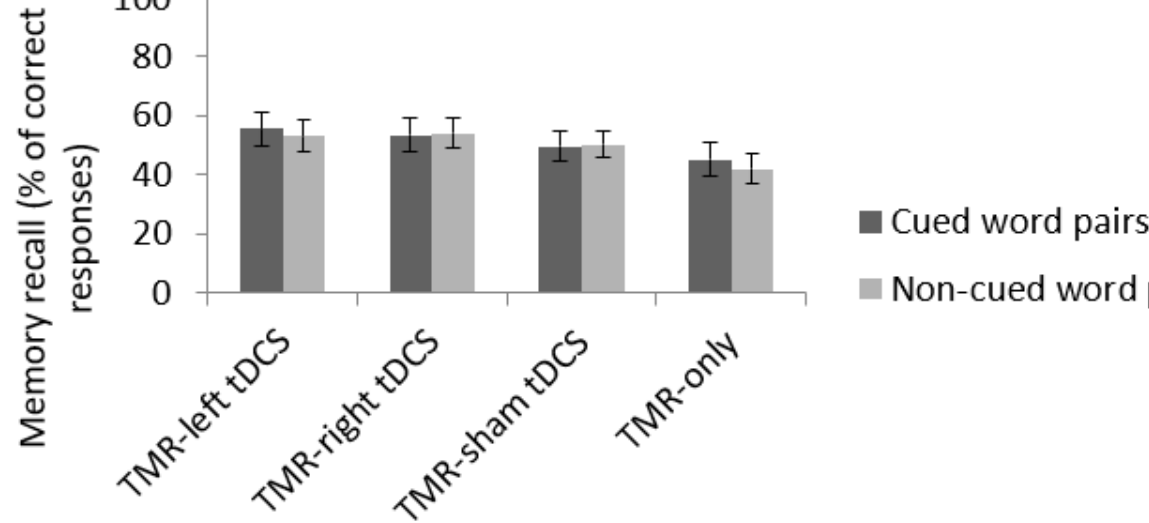
Figure 5. Memory forgetting for cued and non-cued word pairs from immediate (IRT) to delayed (RT2) recall in the four conditions. Error bars illustrate standard error.